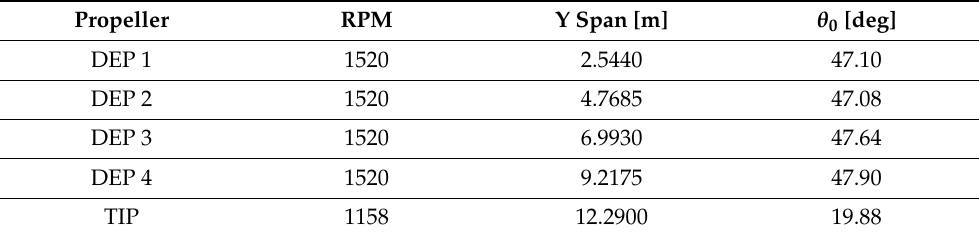
Table 4. Mot. 2: Propellers’ RPM and collective pitch in a 100%-ETR climb.